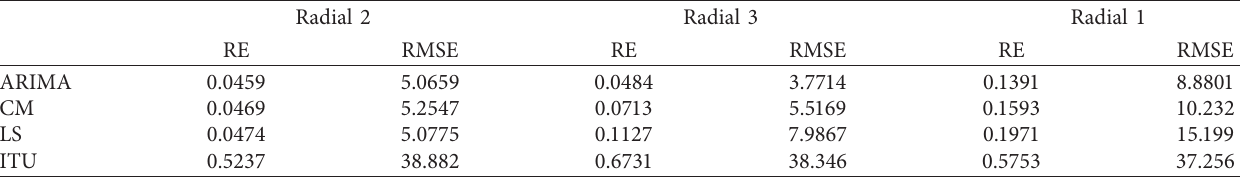
Table 1: RE and RMSE values for original